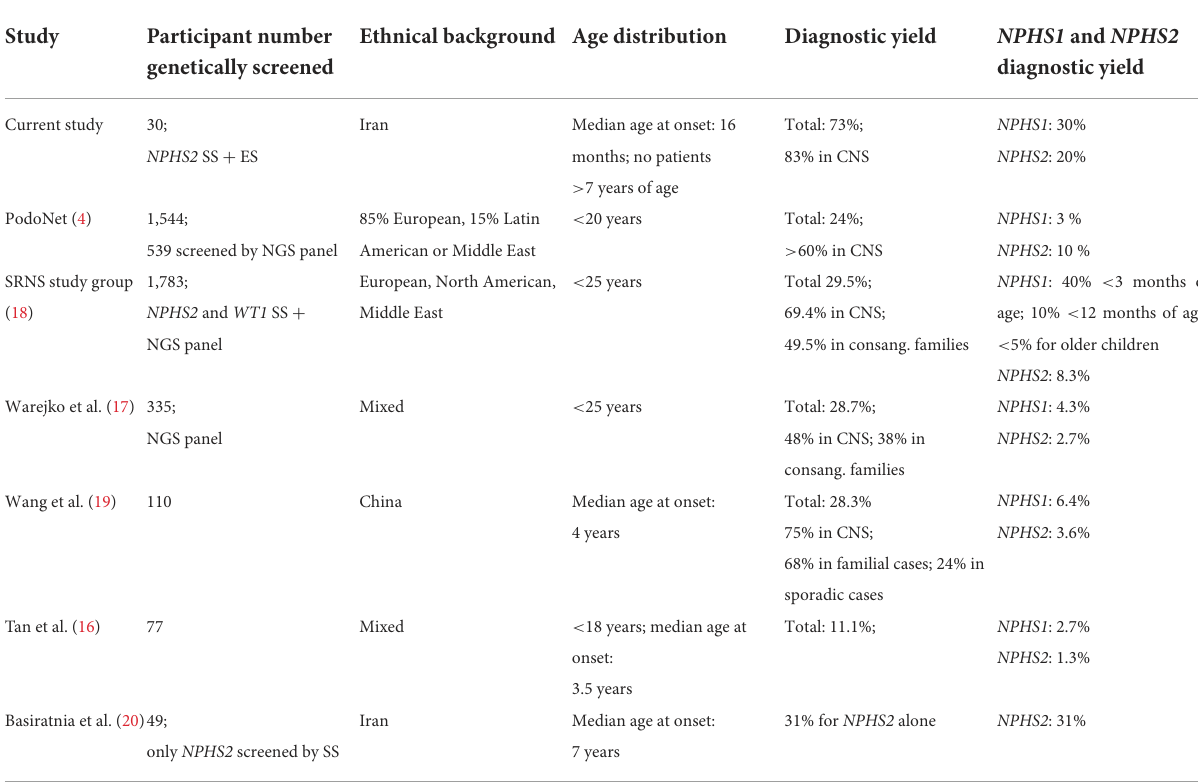
TABLE 2 Comparison of genetic findings in different SRNS